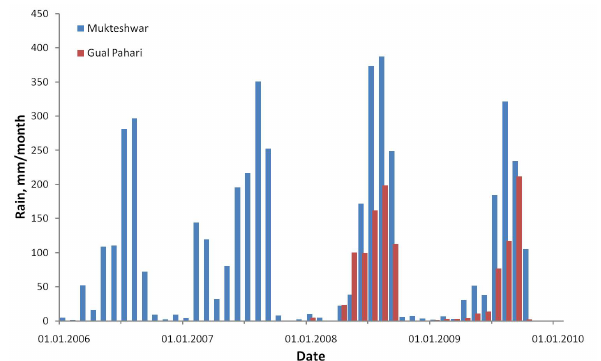
Fig. 2. Monthly rain accumulation during running of the measure- ment